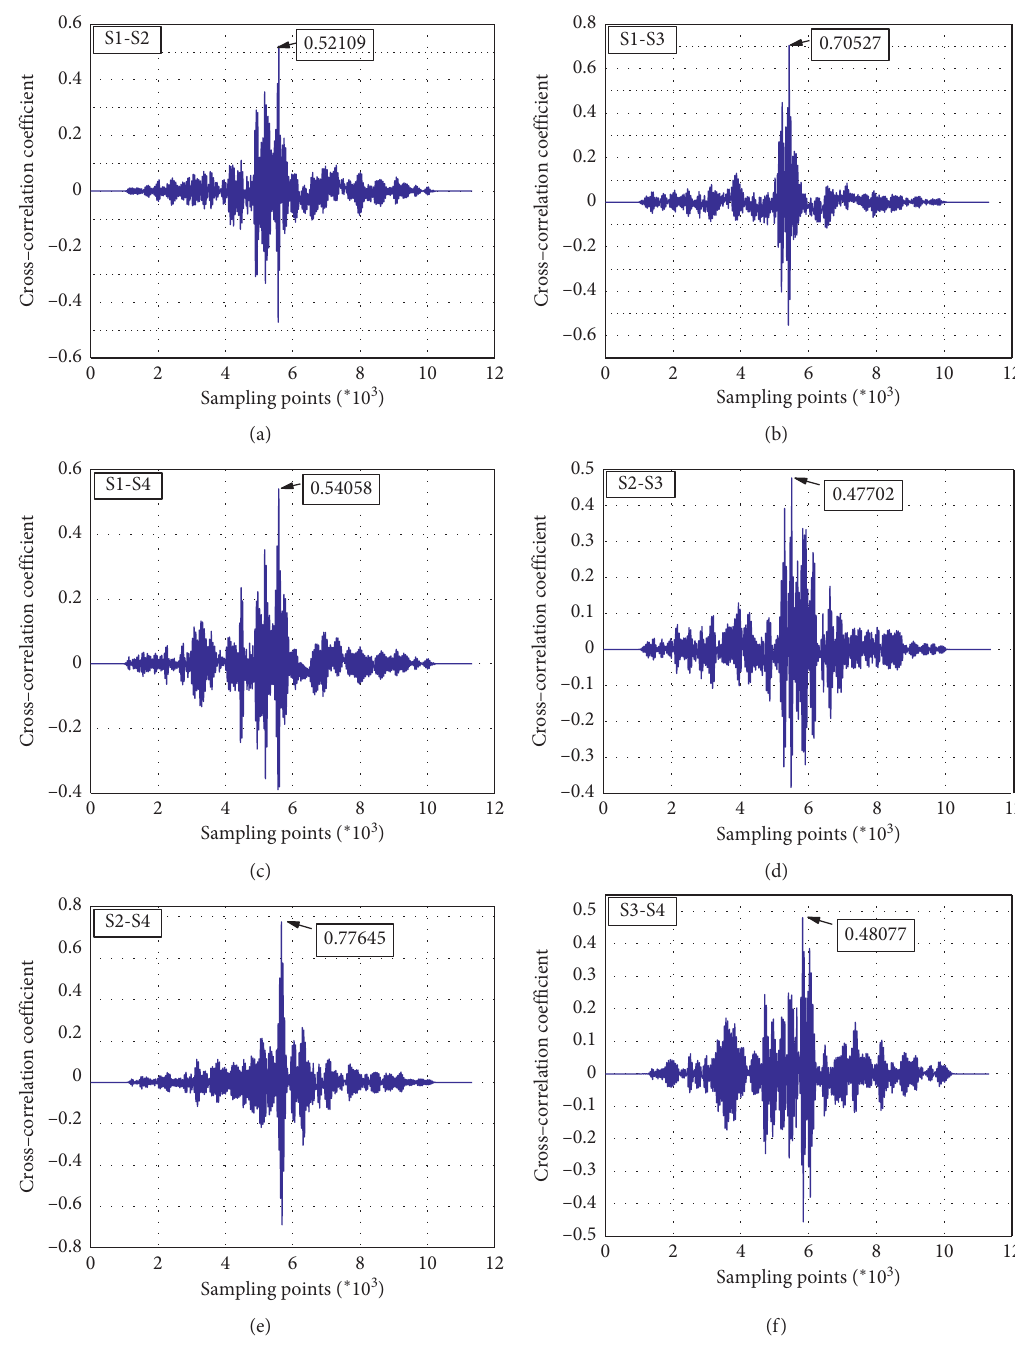
Figure 15: Cross-correlation map after wavelet packet